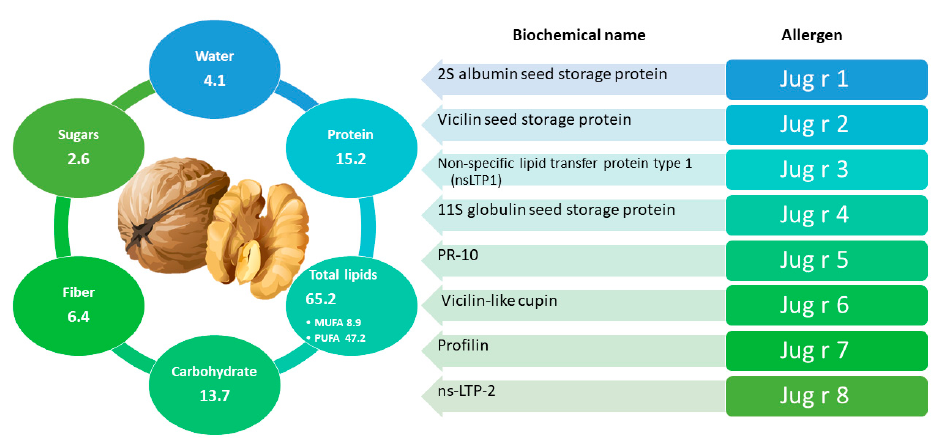
Figure 6. On the left there is the relevant information on the nutritional composition (g/100 g) relating to the Juglans regia species. On the right is the list of allergenic proteins identified and registered to date on the WHO/IUIS online allergen platform.